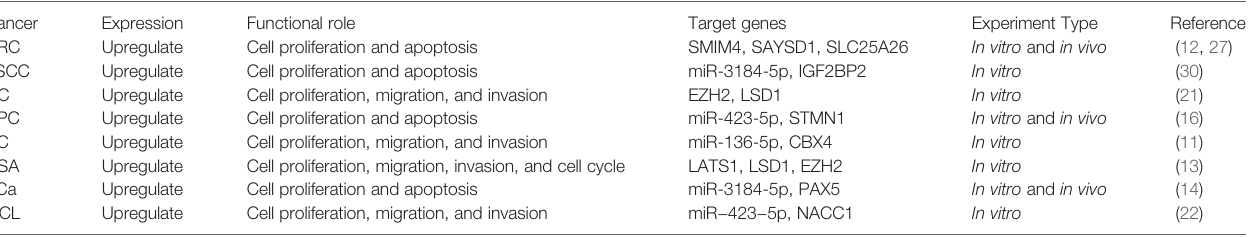
TABLE 4 | Summary of FOXP4-AS1 functional roles and related genes.